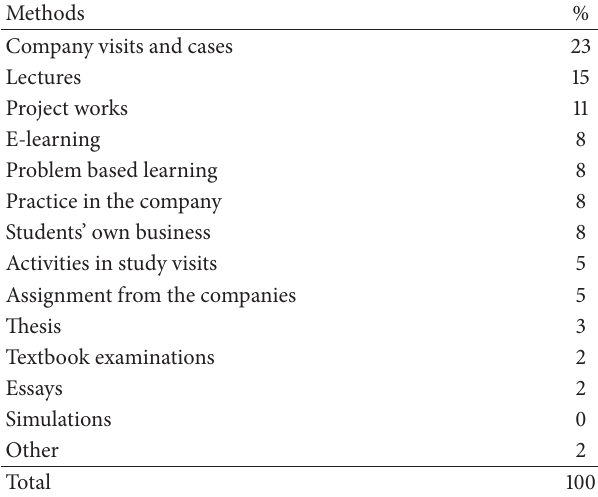
Table 4: Teaching methods.